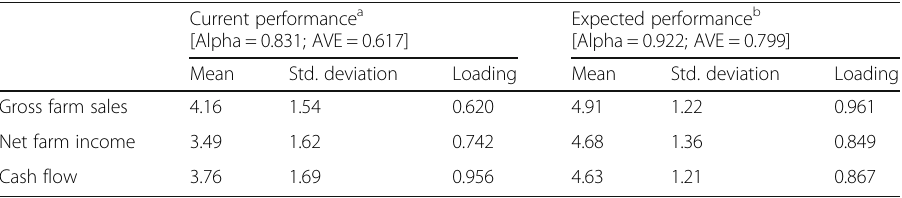
Table 9 Items of performance scales and scale reliabilities Current performance a [Alpha = 0.831; AVE =